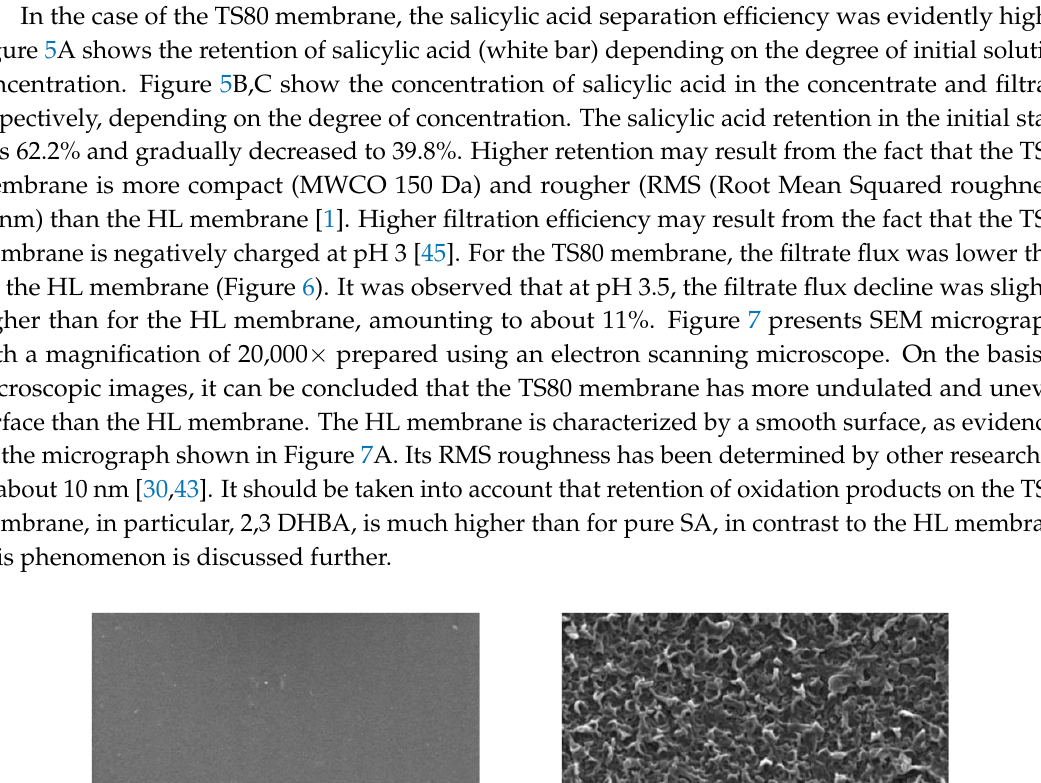
Figure 7. SEM microscopic images of selected membranes at 20,000×: ( A ) HL pure, magnification 20,000×; ( B ) TS80 pure, magnification 20,000×.